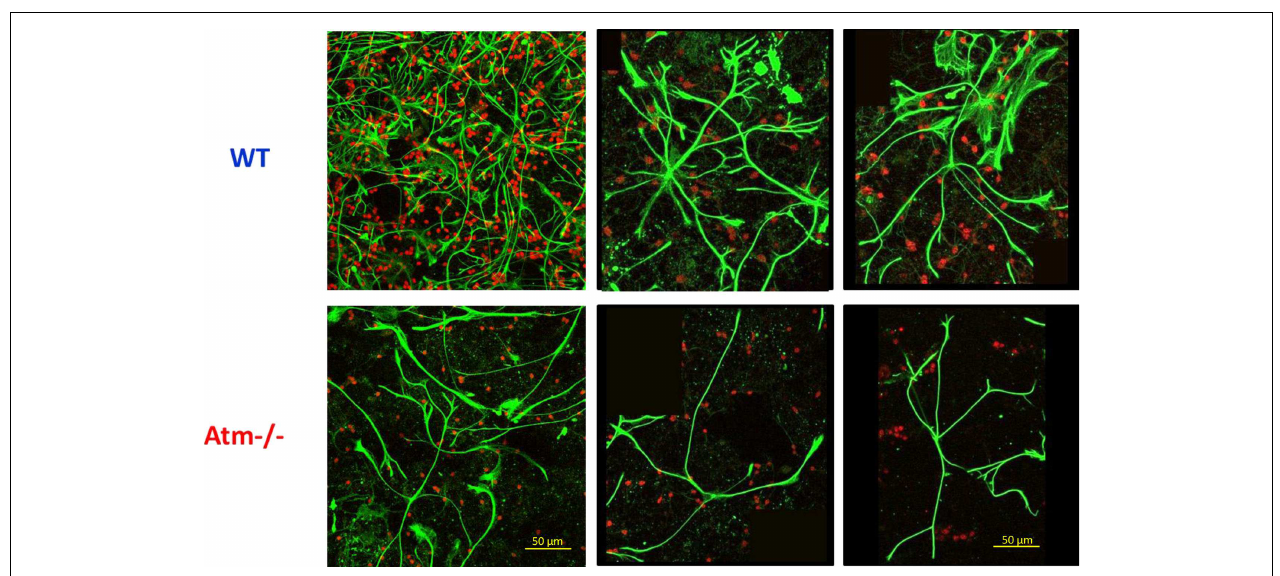
NeuN (red). Note, that Atm − / − astrocytes display significantly less processes in comparison toWT astrocytes. Magnification: left column × 20; center and right column × 40.